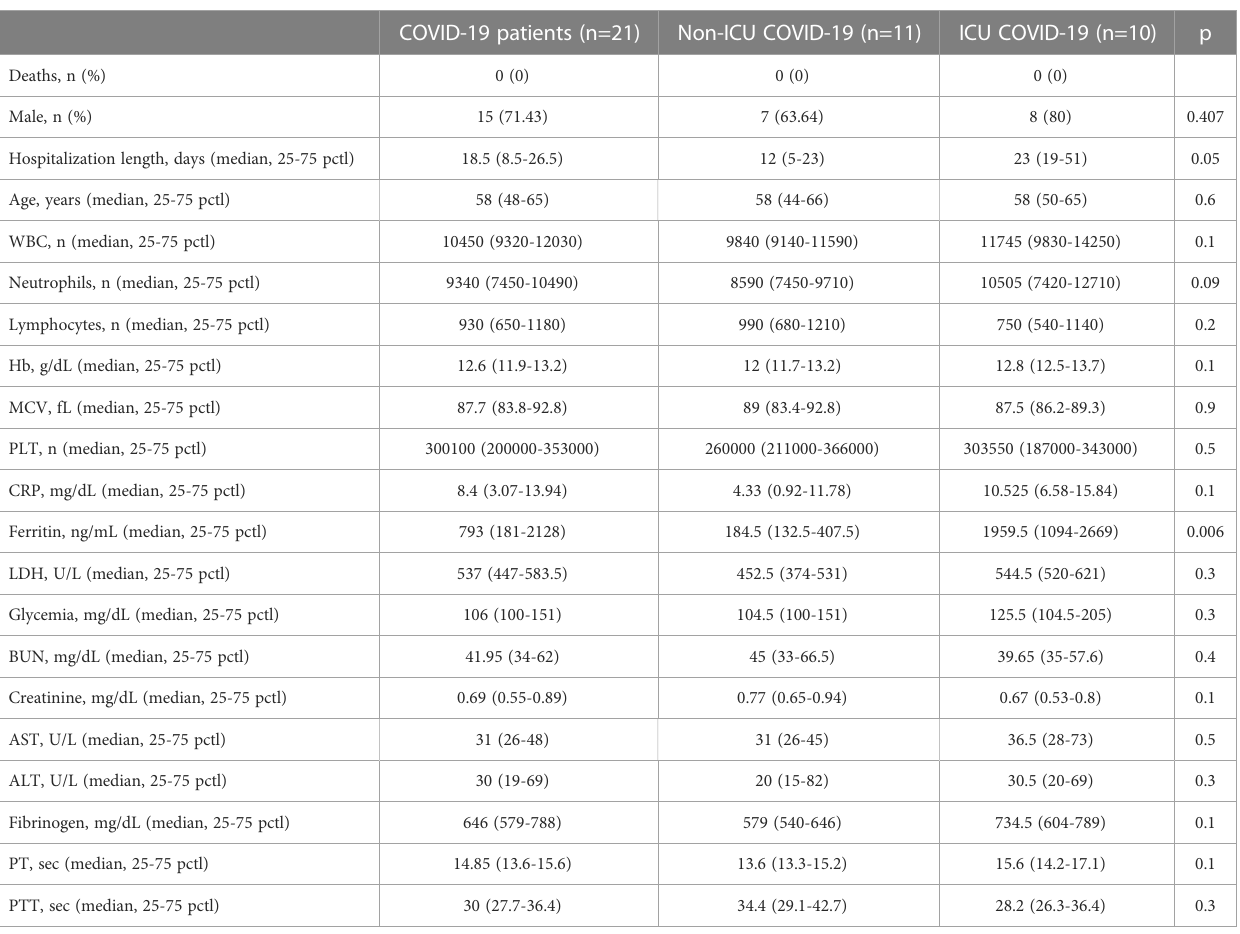
TABLE 1 COVID-19 patients